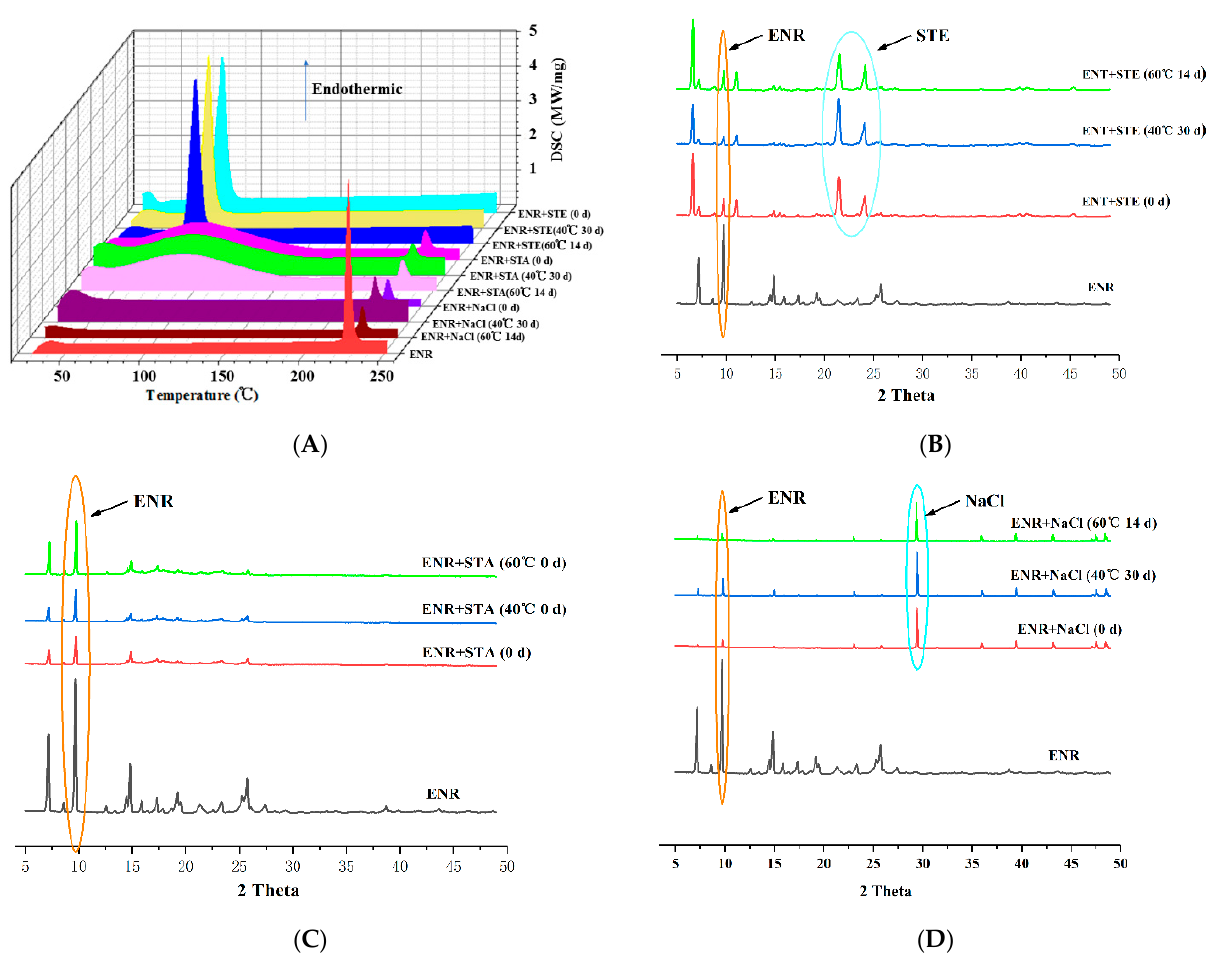
Figure 3. The compatibility of DSC ( A ) and XRD ( B – D ). No specific interactions exist between the excipients and ENR during the compatibility tests. Note: ENR, enrofloxacin; STE, stearic acid; STA, starch.